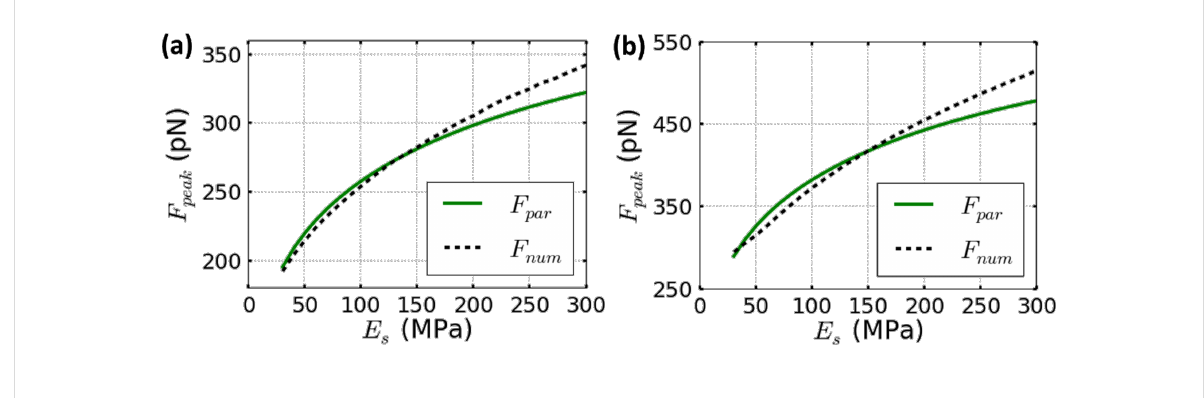
Figure 2: The dependence of the peak forces on the sample Young’s modulus for the parametrical equation of Equation 8 (full line plots) and the cor- responding numerical simulations for Tatara’s contact mechanics model (dashed line plots). (a) A sp = 0.9 A 0 and (b) A sp = 0.7 A 0 . Parameters defined for (a) and (b) are: A 0 = 4 nm, Q = 2, k = 0.1 N/m and R t = 5